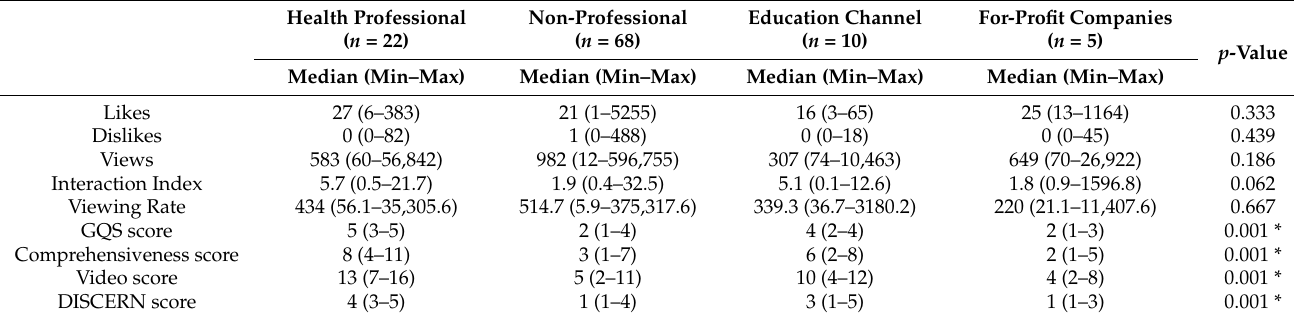
Table 3. Analysis of video variables based on video sources.